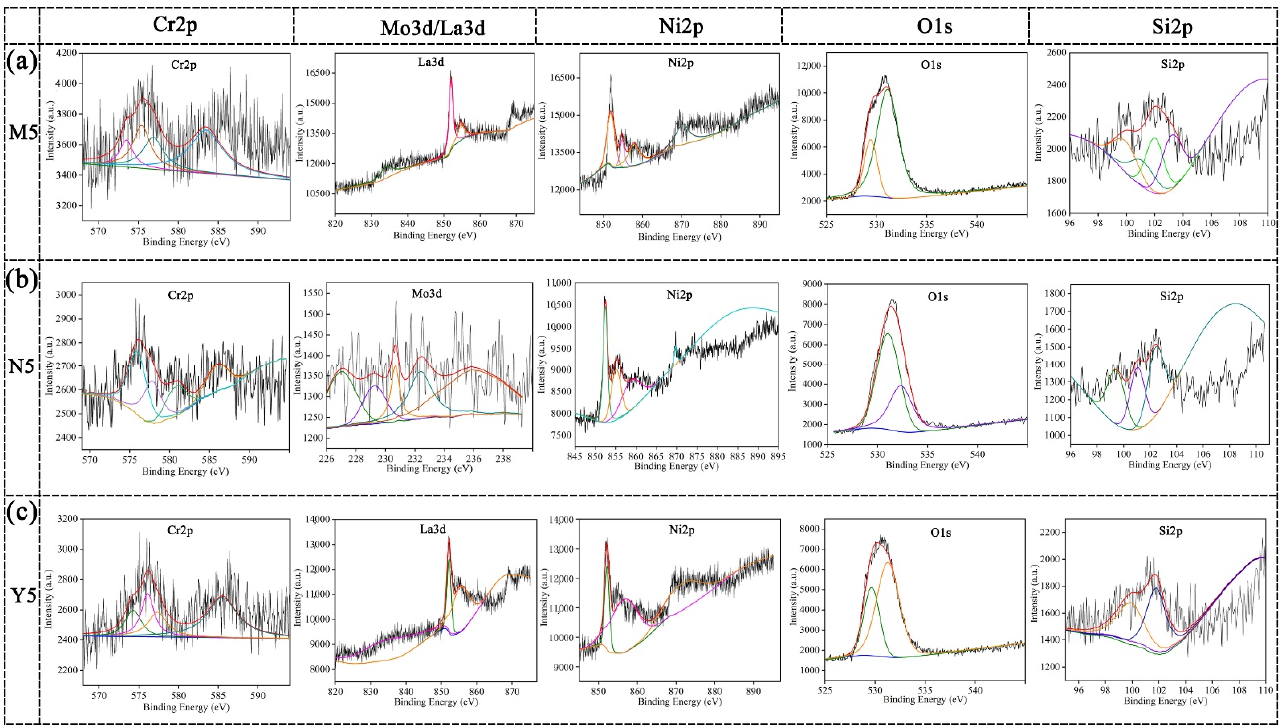
Figure 6. XPS Analysis of Y3, Y4 and Y5 Coating.